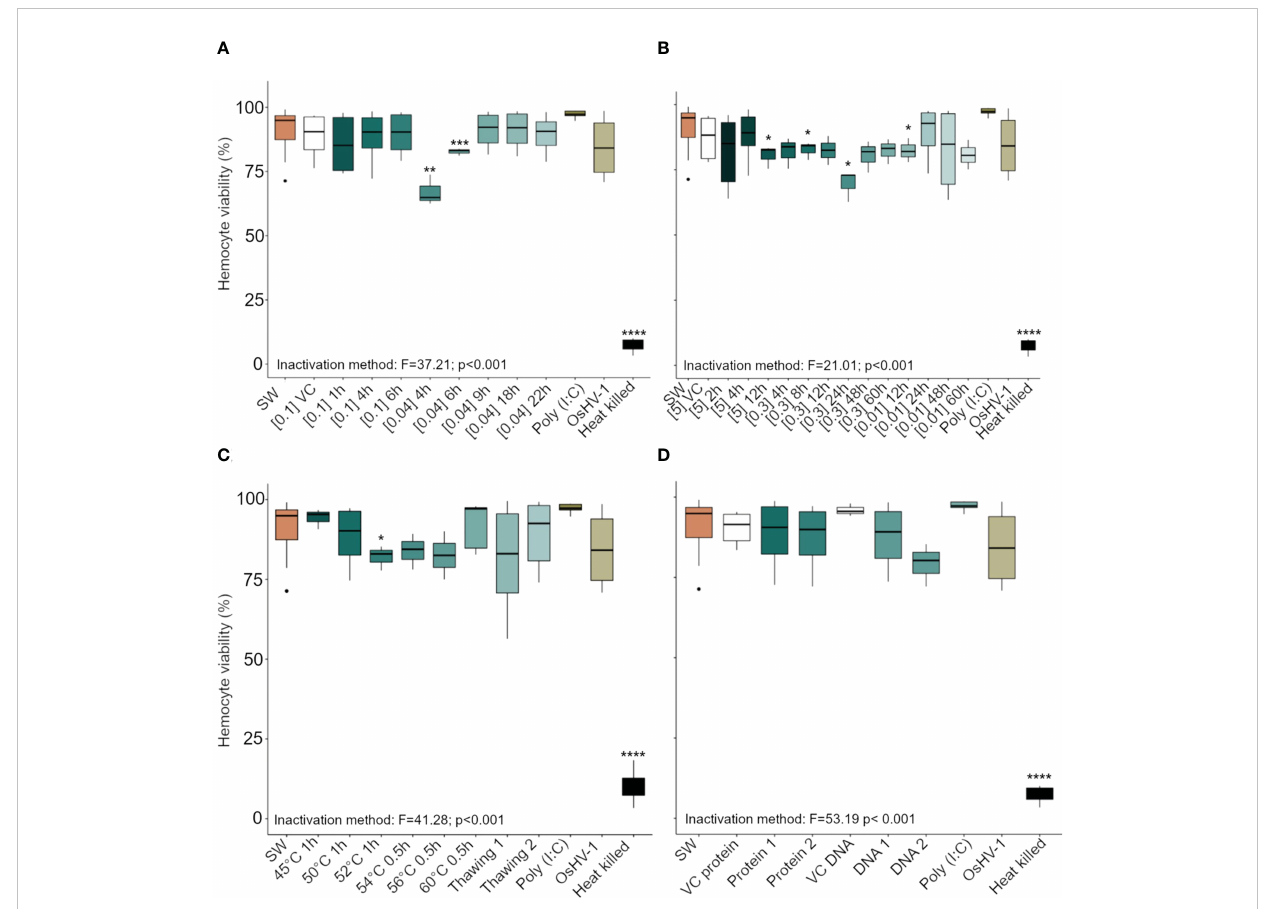
FIGURE 2 Viability (in percent) of Crassostrea gigas hemocytes exposed for 1 h to OsHV-1, which had been inactivated with different preparations of (A) Binary ethylenimine BEI, (B) formaldehyde, and (C) temperature treatments. (D) shows viability of hemocytes exposed to two viral protein concentrations and puri fi ed viral DNA (see Supplementary Table 1 for details of the different treatments). Box plots indicate the median, upper, and lower quartiles. Whiskers indicate the highest and the lowest percent viable hemocytes and dots indicate outliers. Signi fi cance levels are expressed by asterisks: * (p < 0.05), ** (p < 0.01), ***(p < 0.001), **** (p < 0.0001). N = 3/6 replicates. ‘ SW ’ stands for seawater, ‘ VC ’ for vehicle